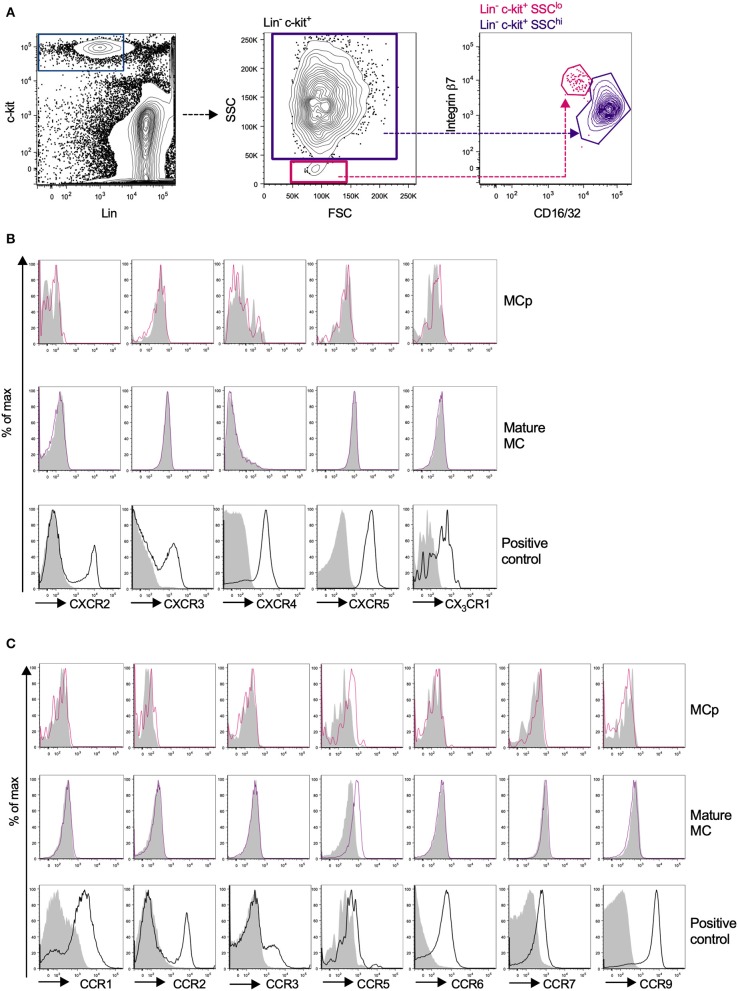
Mouse peritoneal MCp demonstrate CCR5 surface expression but lack expression of other CCR-family, CXCR-family receptors and CX3CR1. Peritoneal cells from naïve BALB/c mice were stained by fluorescently-labeled antibodies and analyzed by flow cytometry. (A) MCp were identified as Lin− c-kit+ SSClo integrin β7hi CD16/32int cells and mast cells as Lin− c-kit+ SSChi integrin β7int CD16/32hi cells. (B) Representative histograms for the analyses of CXCR2-5 and CX3CR1 surface expression on MCp, mast cells (MC) and positive control cells. (C) Representative histograms for the analyses of CCR1-3, CCR5-7, and CCR9 surface expression on MCp, MC and positive control cells. The positive controls for each chemokine receptor are described in Table 3. Pooled cells from three-six mice were used for each individual experiment. Each chemokine receptor was analyzed in two-three separate experiments.